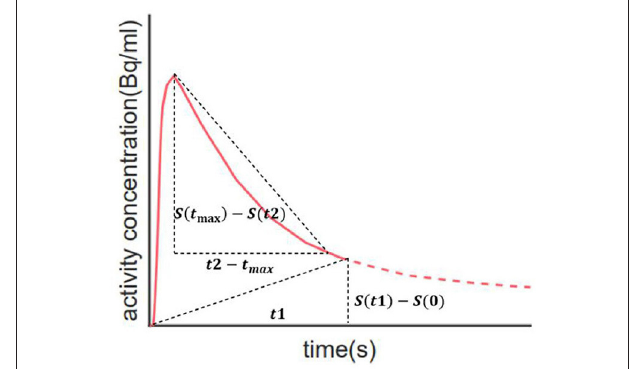
FIGURE 1 | Illustration of how index AQI was calculated. The two oblique dashed lines represent the two slopes that reflect clearance rate and PiB retention respectively. Calculation of AQI only requires 30-min scan, as indicated by the solid red